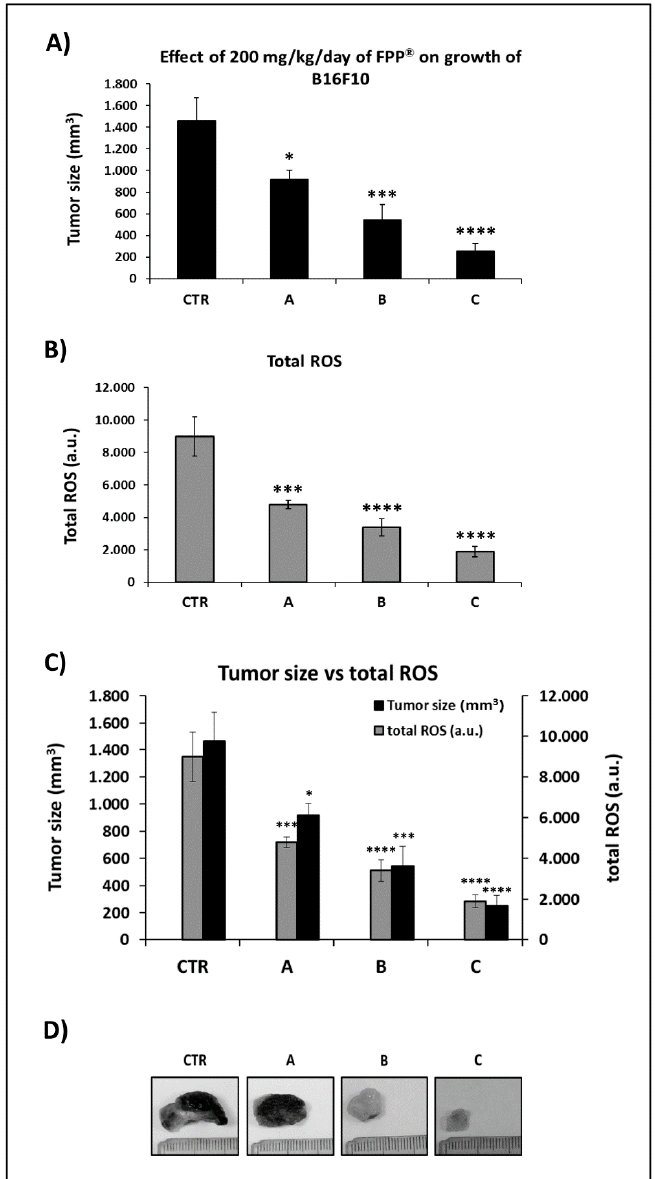
Figure 5. FPP ® antioxidant effect by measuring the blood levels of total ROS. Analysis of the total ROS levels (arbitraty units, a. u.) on the blood lymphocytes taken before the sacrifice of the control mice (untreated) and mice treated daily with FPP ® starting at 21 days before (group A), 14 days before (group B) and 3 days before (group C) the inoculation up to the sacrifice. Mice were treated only sublingually with FPP ® at the concentration of 200 mg/Kg/mouse every day without interruption until the sacrifice of the animals. Analysis of the total ROS levels was performed with a colorimetric assay and measured on a flow cytometer off the 488 nm (blue laser) in the FITC channel. ( A ) Tumor size of B16F10 in untreated mice group (control) and in mice groups treated with 200 mg/Kg/day of FPP ® (groups A, B, C). ( B ) Levels of total ROS in control mice group and in mice groups treated with 200 mg/Kg/day of FPP ® (groups A, B, C). ( C ) Comparison between tumor size and levels of total ROS in control mice group and in mice groups treated with 200 mg/Kg/day of FPP ® (groups A, B, C). ( D ) Size and color of melanoma in mice at sacrifice in control, A, B and C groups. Data are expressed as means ± SE. * p < 0.05, *** p < 0.001, **** p < 0.0001.